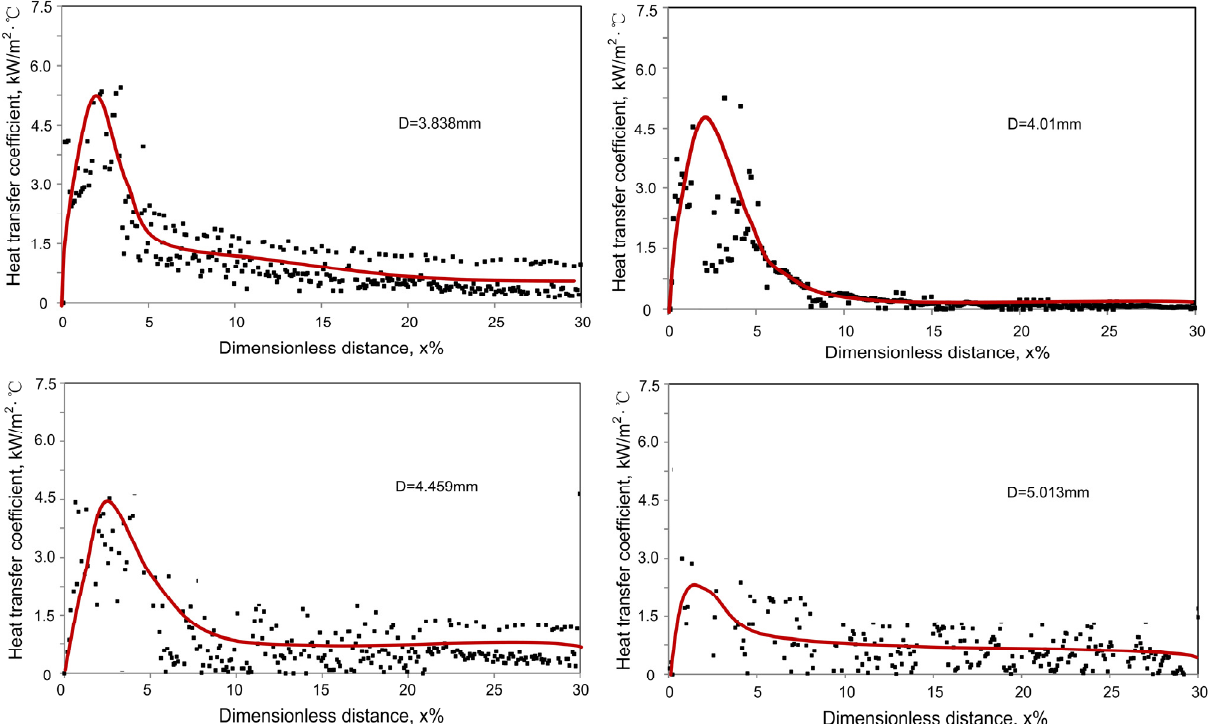
Figure 10. The transient heat transfer coe ffi cient of a single droplet with di ff erent diameters.